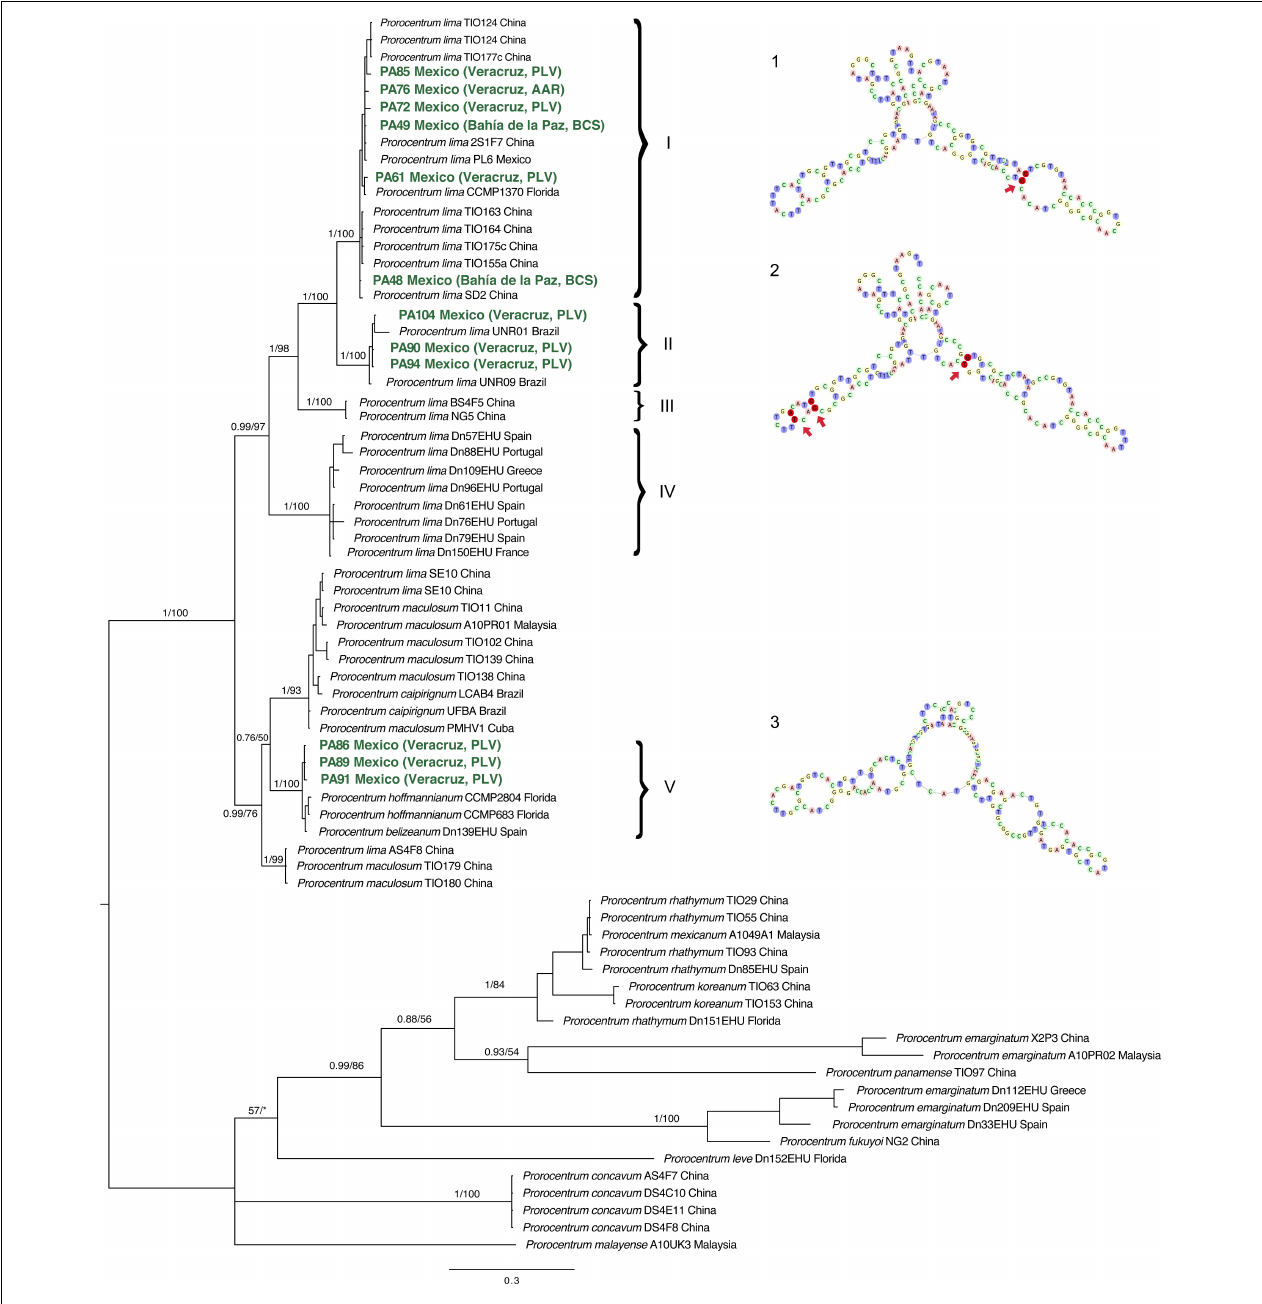
FIGURE 4 | Majority rule consensus of the trees sampled in the Bayesian inference phylogenetic analysis of the ITS/5.8S rDNA sequences of Prorocentrum species, represented by isolates from the Gulf of California, Gulf of Mexico, and Caribbean coasts of Mexico incorporated into a global clade framework from geographical regions. The ITS2 variants of secondary structure (labeled as 1, 2, and 3) correspond with secondary structure of the specimens sampled in this study on each clade. Variant 1 corresponds with clade I, variant 2 with clade II, and variant 3 with P. hoffmannianum . Arrows and deep red dots indicate the distinctive compensatory base changes (CBCs) for each secondary structure for each lineage in P. lima . Values above branches correspond to Bayesian posterior probabilities/bootstrap frequencies, for main branches.